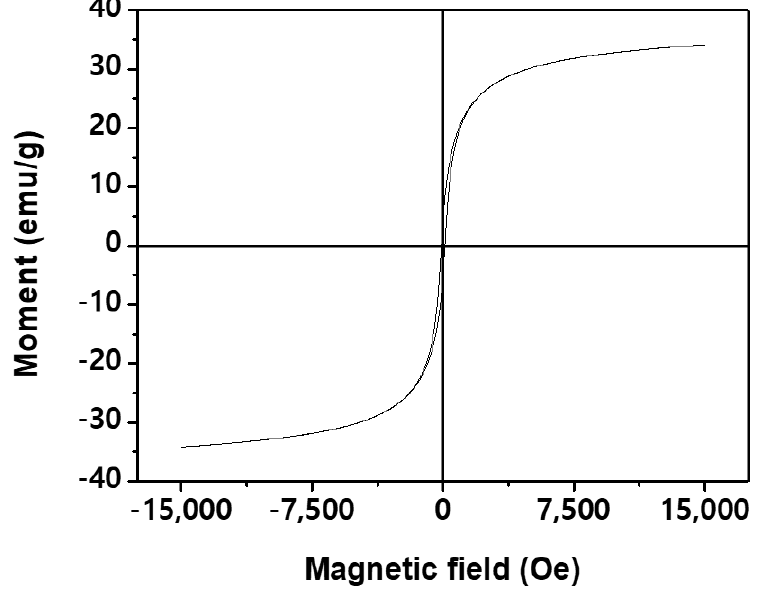
Figure 3. Vibrating sample magnetometer (VSM) analysis result of HWWC.